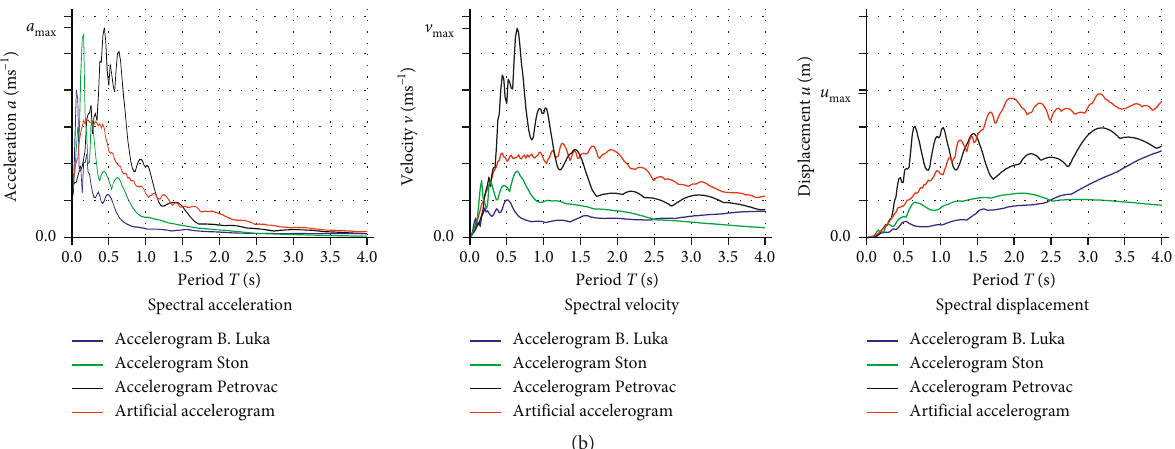
Figure 7: Acceleration time history and elastic response spectra of the applied excitations. (a) Applied horizontal base excitations. (b) Elastic response spectra of applied